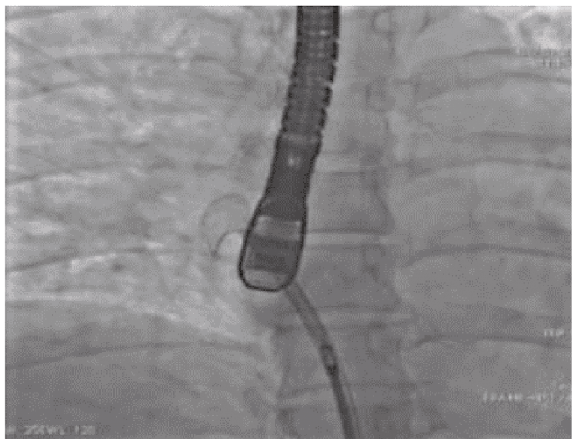
Figure 3: Percutaneous PFO closure with a Figulla Flex II PFO occluder. Right side portion of the device opened in the right atrium.